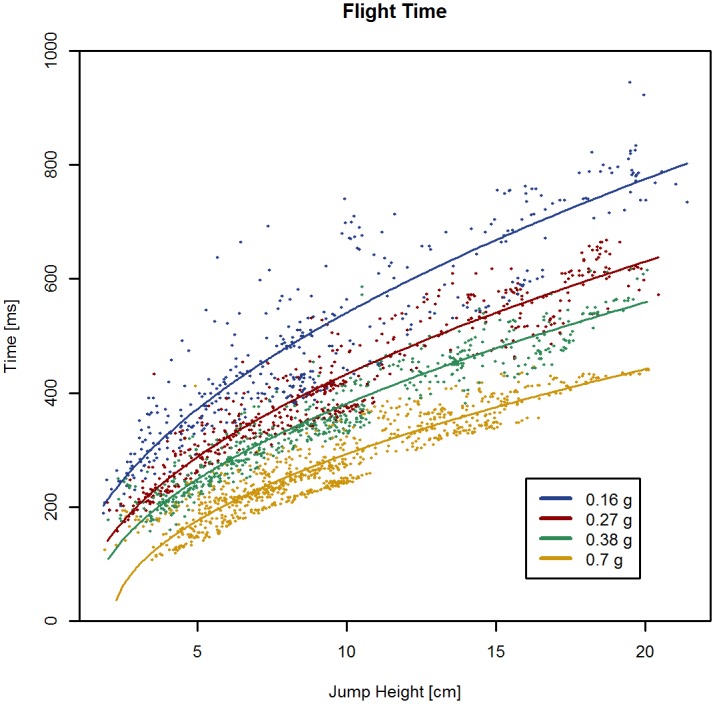
Flight time (Tf).Composite Tf signals of all hopping trials are depicted. A square-root function has been fitted to the data. Flight time increased significantly with decreasing gravity levels and increasing jump heights (height of flight; P < 0.001).